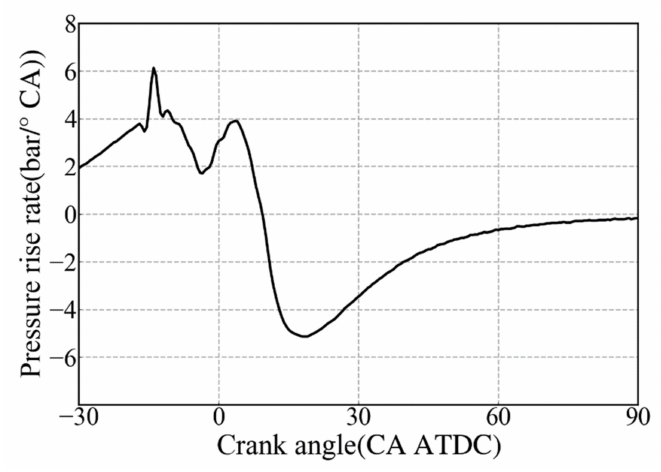
Figure 4. Pressure Rise Rate.